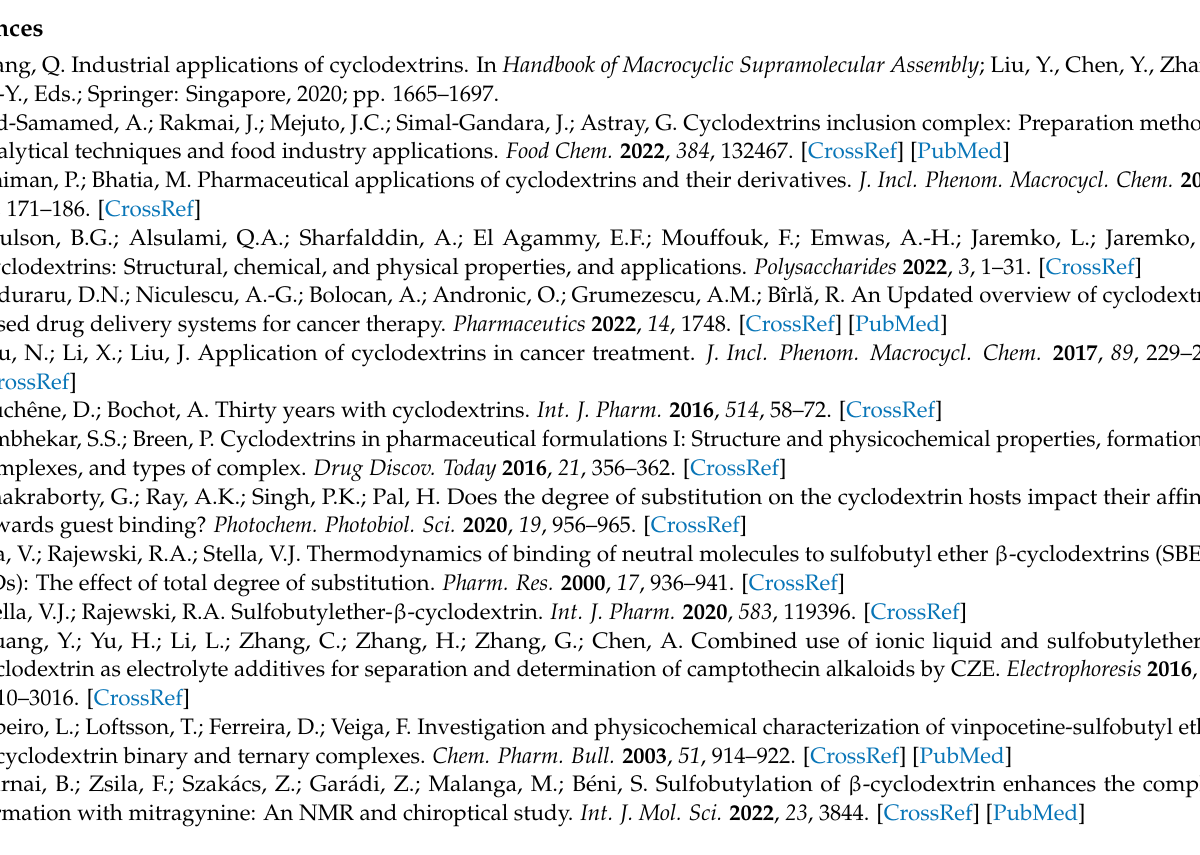
after subtraction of the dilution heats of C and SBE 6.4 β CD as a function of [C]/[SBE 6.4 β CD] molar ratio; Figure S9: (a) ITC traces for the titration of 16.2 mM SBE 6.4 β CD solution with water (black line) and 0.84 mM P solution (red line). Absorbed heat upon the addition of 0.84 mM P solution into water (green line); 40 µ L aliquots were injected into 1.433 mL volume. (b) The integral of the evolved heat after subtraction of the dilution heats of P and SBE 6.4 β CD as a function of [P]/[SBE 6.4 β CD] molar ratio; Figure S10: (a) ITC traces for the titration of 20.1 mM SBE 6.4 β CD solution with water (black line) and 1.07 mM E solution (red line). Absorbed heat upon the addition of 1.07 mM E solution into water (green line); 40 µ L aliquots were injected into 1.433 mL volume. (b) The integral of the evolved heat after subtraction of the dilution heats of E and SBE 6.4 β CD as a function of [E]/[SBE 6.4 β CD] molar ratio; Figure S11: (a) ITC traces for the titration of 24.8 mM SBE 6.4 β CD solution with water (black line) and 1.10 mM DHC solution (red line). Absorbed heat upon the addition of 1.10 mM DHC solution into water (green line); 40 µ L aliquots were injected into 1.433 mL volume. (b) The integral of the evolved heat after subtraction of the dilution heats of DHC and SBE 6.4 β CD as a function of [DHC]/[SBE 6.4 β CD] molar ratio